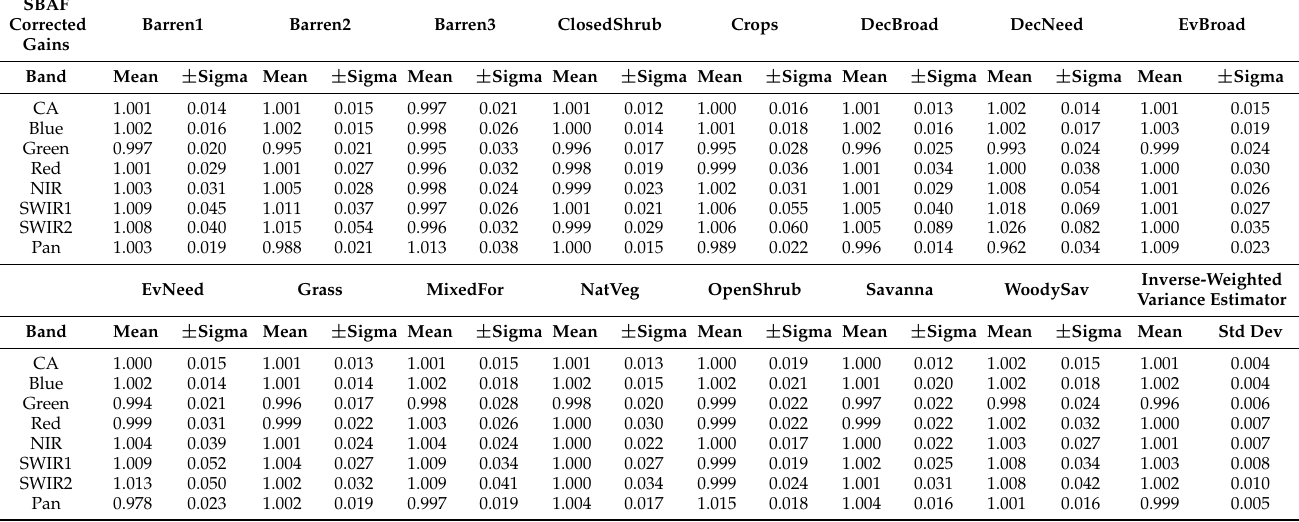
Table 8. SBAF-corrected cross-calibration gains. The inverse-weighted mean variance estimation results were the values recommended to USGS EROS for final reflectance cross-calibration. Note how the values are within 0.5% of unity, which further supports how effective Phase 1